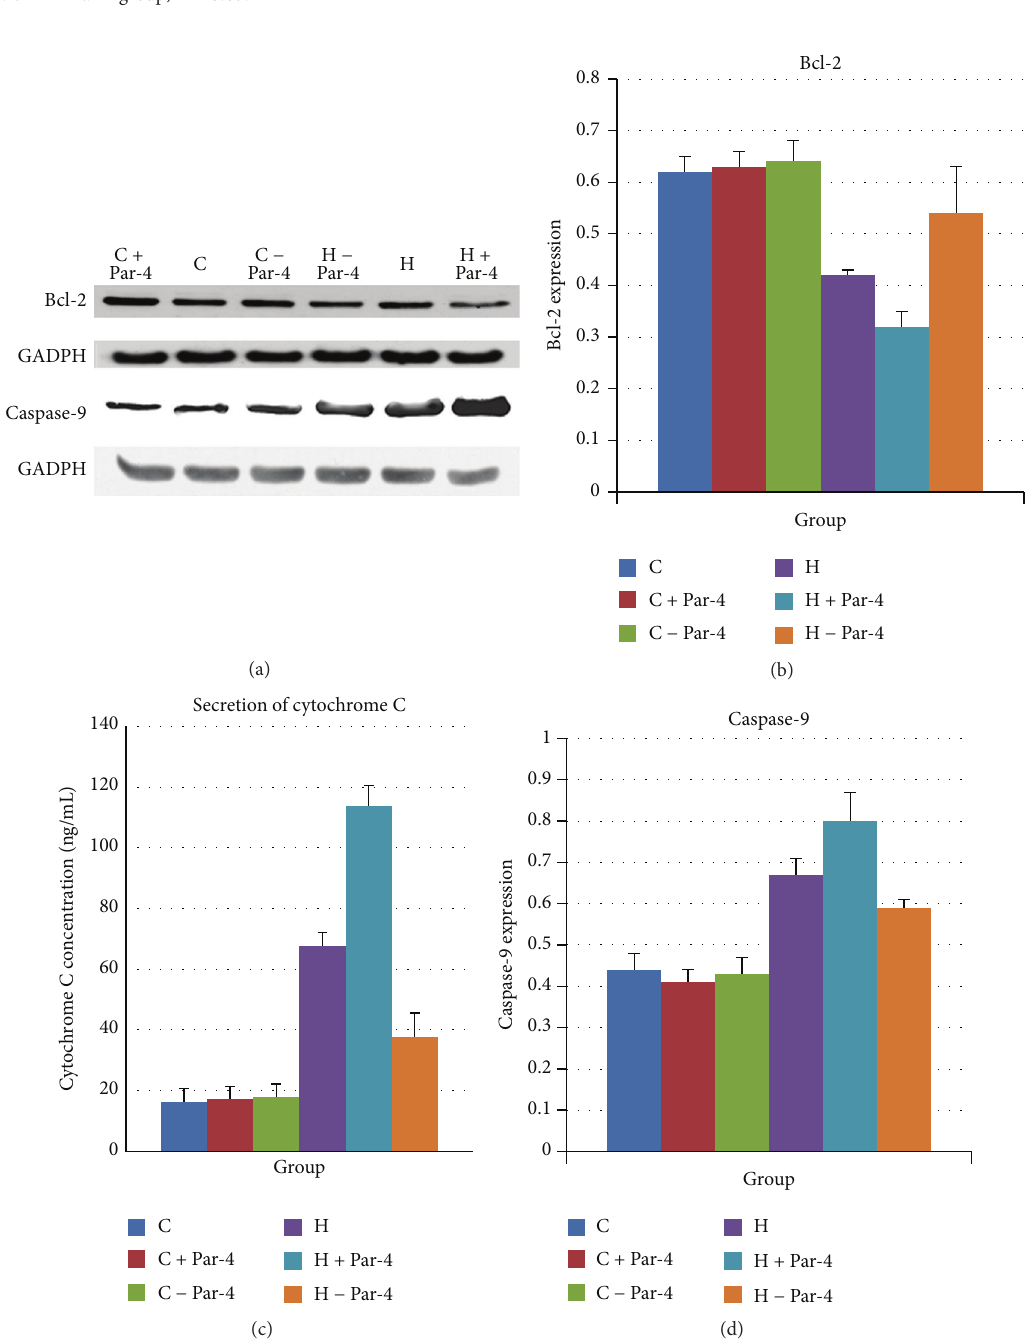
Figure 5: Glucose and palmitate cointervention activates Par-4 via the mitochondrial apoptotic pathway to induce NIT-1